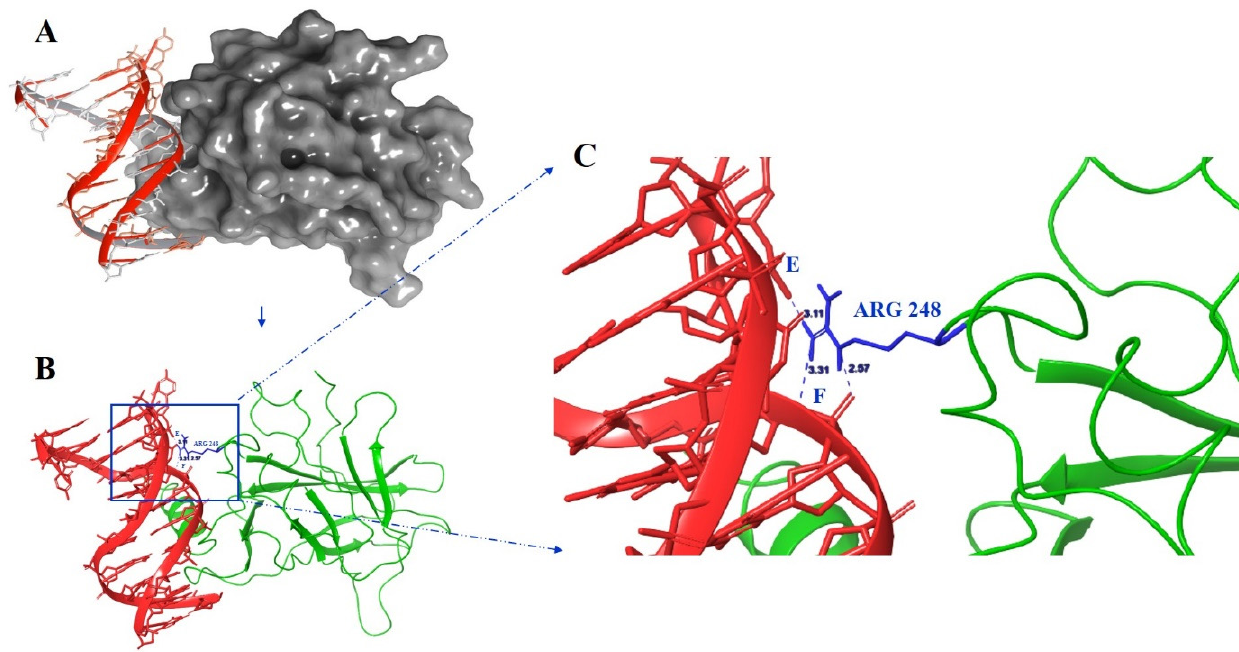
Figure 1. ( A ) The p53–DNA complex structure was obtained from the Maestro suite. The DNA is represented in the red cartoon, and their atoms are shown as red stick models, whereas the protein surface is represented in the grey surface model. ( B ) The 3D structure of the p53 protein (PDB ID-2AC0) shows the p53 protein (labeled in green color) interacting with DNA (labeled in red). Blue box highlighted the three H-bonds with wild-type Arg-248 residue (marked in blue) and their distance are blue labeled in Å. ( C ) Interaction of DNA with R248 residue of p53. DNA chain E of 2AC0 structure formed a hydrogen bond with chain A of R248 residue of p53 protein with (A: Arg248:NH2-E:Gua12:O2P). Similarly, DNA chain F of 2AC0 structure formed two H-bonds with chain A of R248 residue of p53 protein (A:Arg248:NH2-FAde6:O3 (cid:48) and